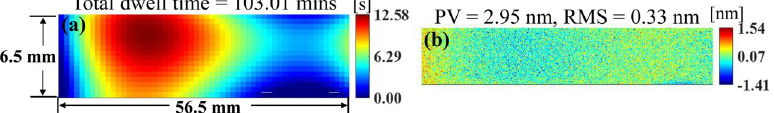
Figure 5. Dwell time map resampled to 1 mm sampling interval ( a ) and the corresponding residual map in CA ( b ).